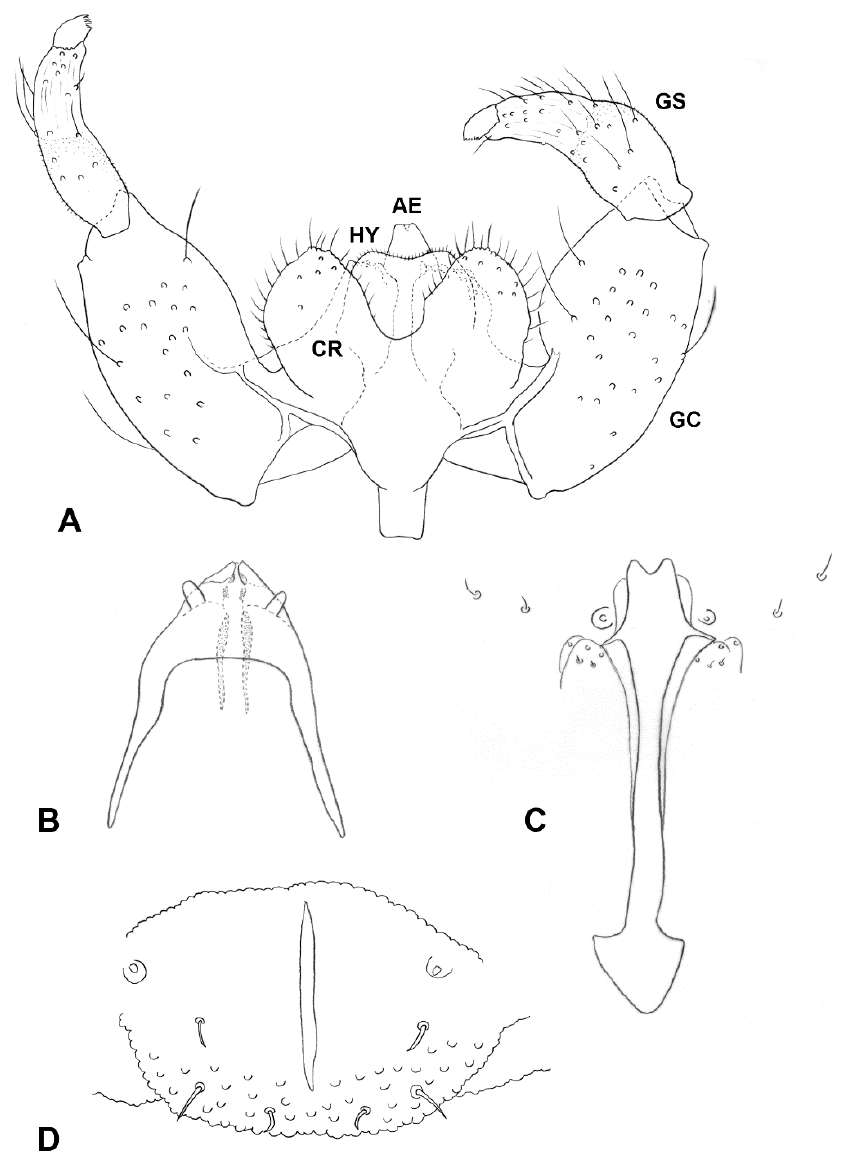
Figure 5. Ruschiola succulenta . ( A ) Male terminalia, dorsal. ( B ) Larva, head. ( C ) Larva, spatula and associated papillae. ( D ) Larva, terminal abdominal segment. AE: aedeagus; CR: Cerci; GC: gonocoxite; GS: gonostylus; HY: hypoproct. Lampranthus haworthii (Donn ex Haw.)